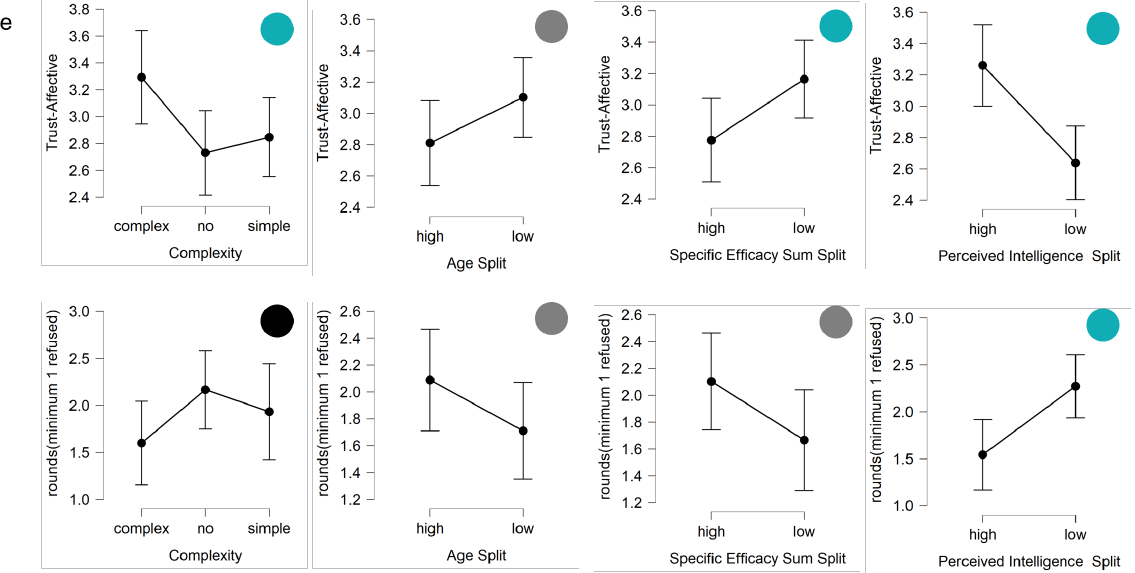
Figure 6. Results regarding ethical explanation objectives (trust and rejection behavior). The first column shows the impact of explanation complexity (complex, no, simple). The other columns show the influences of the human dimensions (age, domain-specific self-efficacy, and mind attribution).